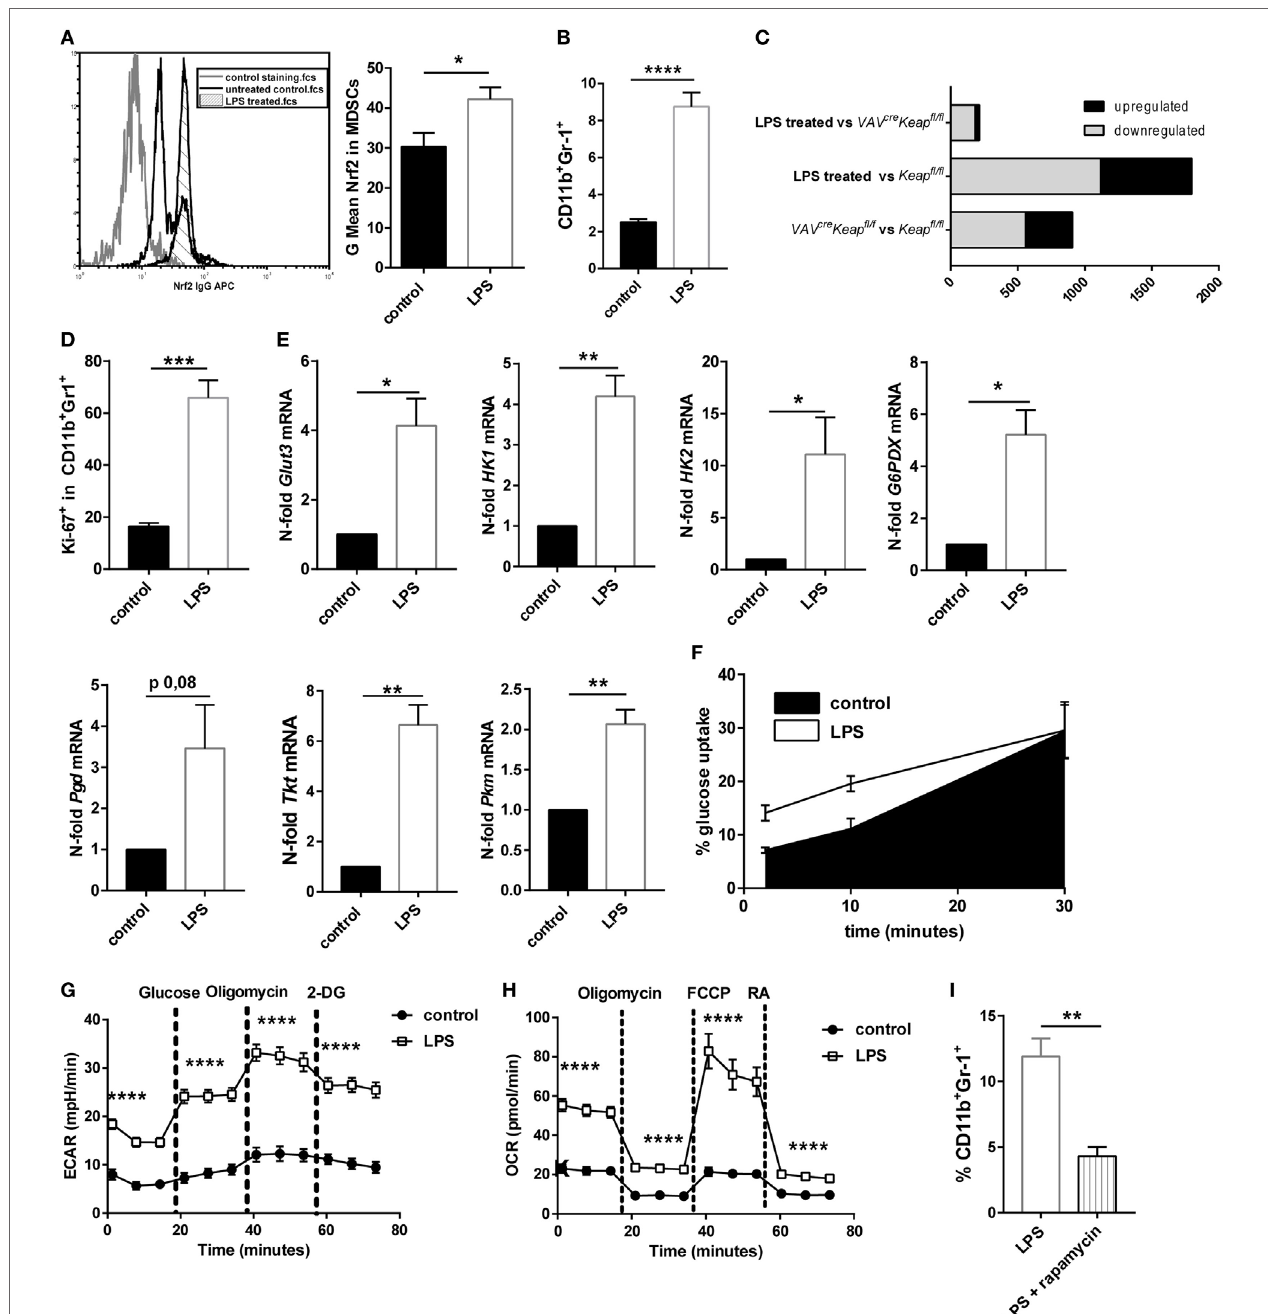
FigUre 6 | Nrf2 activation resembles LPS-induced myeloid-derived suppressor cell (MDSC) expansion. (a) MFI of Nrf2 expression in CD11b + Gr-1 + cells of untreated mice and mice after low-dose LPS treatment, unpaired one-tailed t -test, n = 3. Bars indicate mean ± SEM. (B) Flow cytometric analysis of CD11b + Gr-1 + cells in spleens from untreated Keap fl/fl mice and mice after LPS treatment. Bars indicate mean and error bars SEM of three experiments with a total of nine mice per group. (c) Diagram of differentially expressed genes ( p < 0.05, > 2-fold) between LPS-induced MDSCs vs. VAV cre Keap fl/fl (top), LPS-induced MDSCs vs. Keap fl/fl (middle), and of VAV cre Keap fl/fl and WT (bottom). (D) Statistical analysis of Ki-67 expression in pre-gated splenic CD11b + Gr-1 + cells from untreated ( n = 4) and LPS treated ( n = 4) mice. Bars indicate mean of mean fluorescence intensity and error bars SEM, two-tailed, unpaired t -test. (e) N-fold mRNA expression of metabolic enzymes in MACS isolated CD11b + Gr-1 + cells analyzed by RT-qPCR. Bars indicate mean and error bars SEM, n = 5, two-tailed, one sample test. (F) 2NBD-glucose incorporation was analyzed in CD11b + Gr1 + splenocytes from control ( n = 6) and LPS treated Keap fl/fl mice ( n = 6) mice at different time-points. (g) ECAR measured under basal conditions and after addition of the indicated drugs. Points indicate mean from three control and three LPS treated Keap fl/fl mice ± SEM of quintuplicates. (h) OCR measured under basal conditions and after addition of the indicated drugs. Points indicate mean CD11b + Gr-1 + cells from three control and three LPS treated Keap fl/fl mice ± SEM of quintuplicates. (i) Flow cytometric analysis of CD11b + Gr-1 + cells in spleens from Keap fl/fl mice 4 days after LPS treatment and daily administration of vehicle or rapamycin. Bars indicate mean and error bars SEM of three experiments with a total of four mice per group.